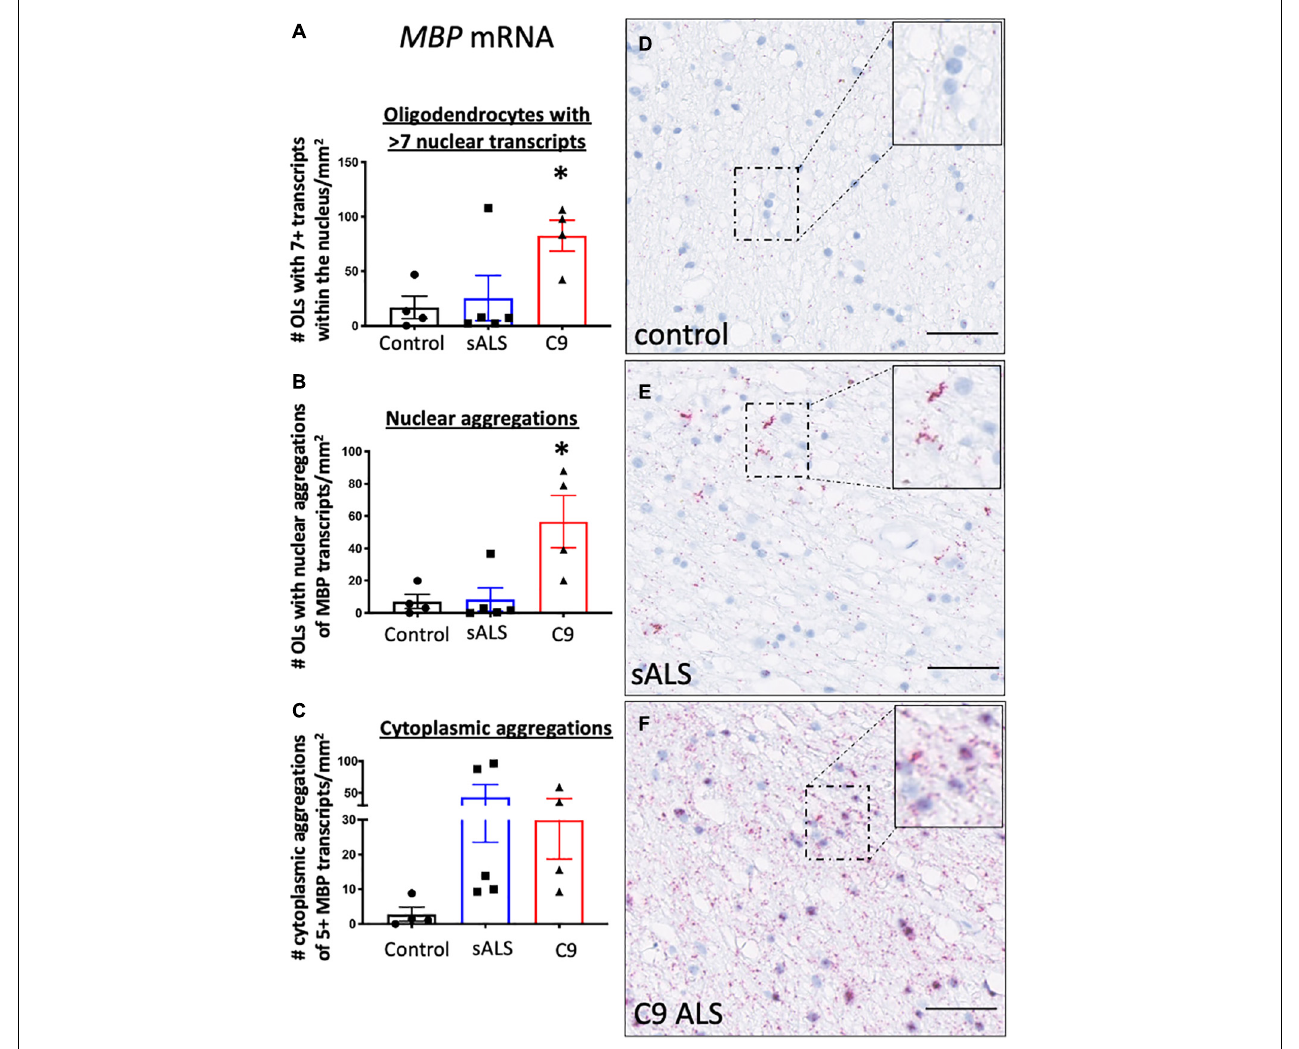
FIGURE 1 | RNA trafficking of myelin basic protein ( MBP) is dysregulated in oligodendrocytes. MBP mRNA transcript localization is altered in sporadic ALS (sALS) patients and ALS patients with a C9orf72 mutation (C9 ALS) compared to controls. (A) Graph demonstrating number of oligodendrocytes (OLs) with 7 or more nuclear MBP transcripts. Data show that C9orf72 ALS cases had a higher proportion of nuclei with > 7 transcripts ( p < 0.05 compared to control; n = 4–5 cases for each genotype). (B) Graph demonstrating number of oligodendrocytes (OLs) with aggregations of MBP transcripts. Data show that C9orf72 cases have more nuclear aggregations of MBP transcripts ( p < 0.05 compared to control; n = 4–5 cases for each genotype). (C) Graph demonstrating number of cytoplasmic aggregations of MBP transcripts. Some sALS and C9orf72 cases have more cytoplasmic aggregations than control individuals ( n = 4–5 cases for each genotype). (D) Representative image from a control case showing MBP positive transcripts within the cytoplasm and cellular processes. (E) Representative image of a sALS case showing prominent cytoplasmic aggregates of transcripts. (F) Representative image from a C9orf72 case demonstrating prominent nuclear and cytoplasmic aggregations of transcripts. * denotes p < 0.05. Scale bar = 50 µ